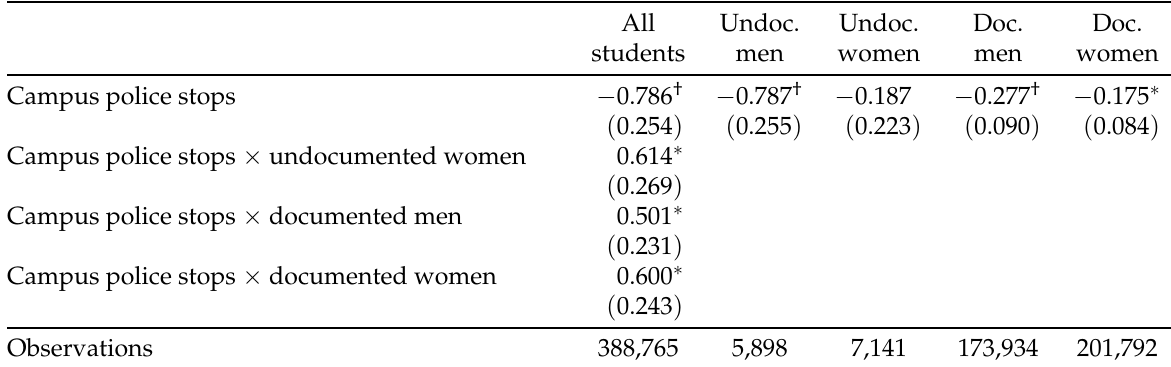
Table 3: Effect of campus police stops on course credits by documentation status and